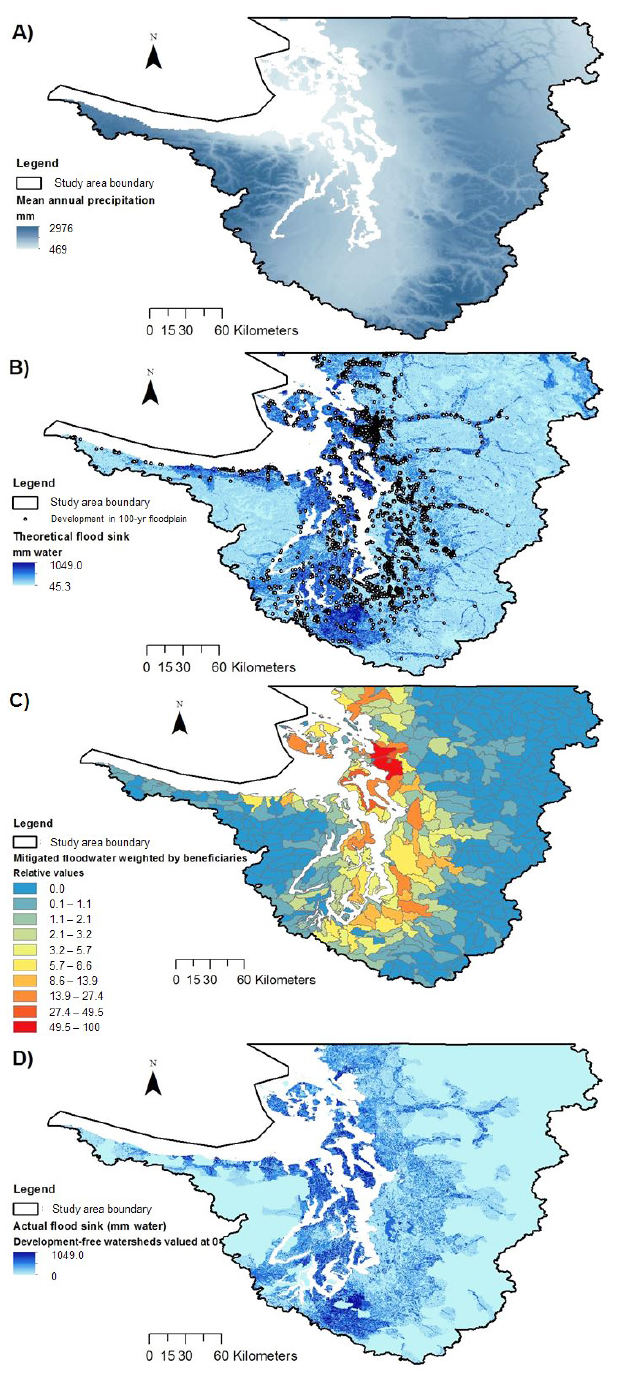
Fig. 6 . Theoretical and actual values for flood regulation in the Puget Sound Basin, showing (a) sources, (b) theoretical sinks and users, (c) actual values weighted by the number of users, and (d) theoretical values providing actual flood regulation.